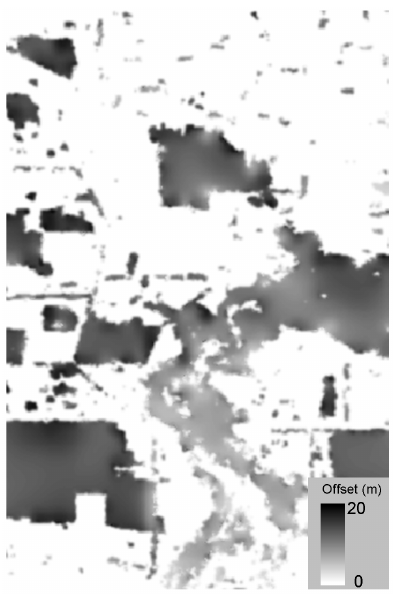
Figure 2. Estimated tree height offset for the area shown in Figure 1.